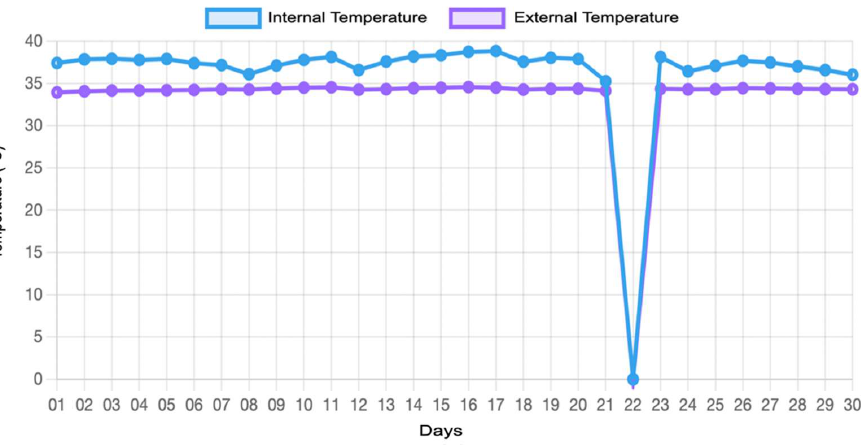
Figure 4. Temperature graphs of Jun 2022, taken by the statistical trends service User Interface (Internal frame temperature, External Temperature in the beehive inner lid